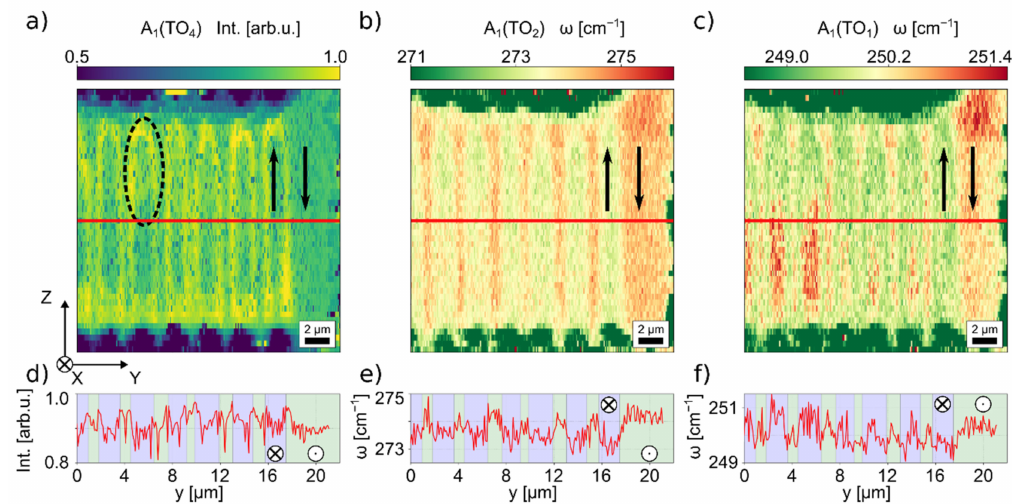
Figure 10. Hyperspectral Raman colormaps of an x-cut PP-TFLN sample ( a – c ), and ( d – f ) the respective cross-sections taken along the indicated red lines in ( a – c ). The step size of the measure points is 0.5 µ m along the TFLN z -axis and 0.1 µ m along the y -axis. ( a ) The A 1 (TO 4 ) intensity provides a net DW contrast with a suspected sensitivity to check for poling completeness, for instance, as in the circled area. ( b ) The A 1 (TO 2 ) frequency reveals a domain polarity contrast. ( c ) The frequency of A 1 (TO 1 ) also shows the DW contrast with a suspected sensitivity to check for poling completeness, and is assumed to be sensitive to stress fields, as